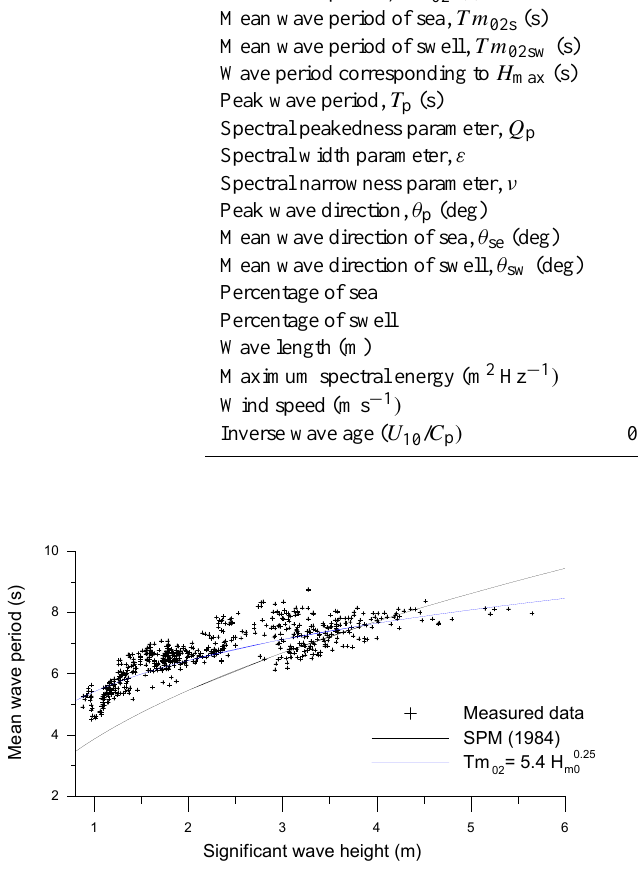
Figure 3. Variation of mean wave period with significant wave height Fig. 3. Variation of mean wave period with significant wave